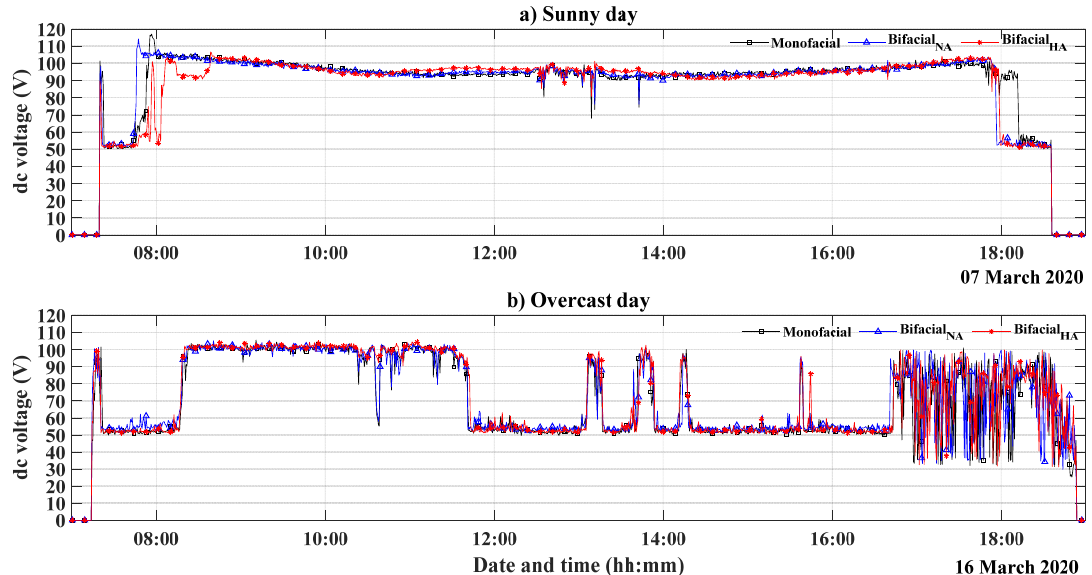
Figure 9. Measured DC voltage (MPPT) during sunny and overcast days; ( a ) Sunny day: the MPPT voltage is around 100 V. ( b ) Overcast day: the MPPT voltage is around 50 V during very low irradiance periods.